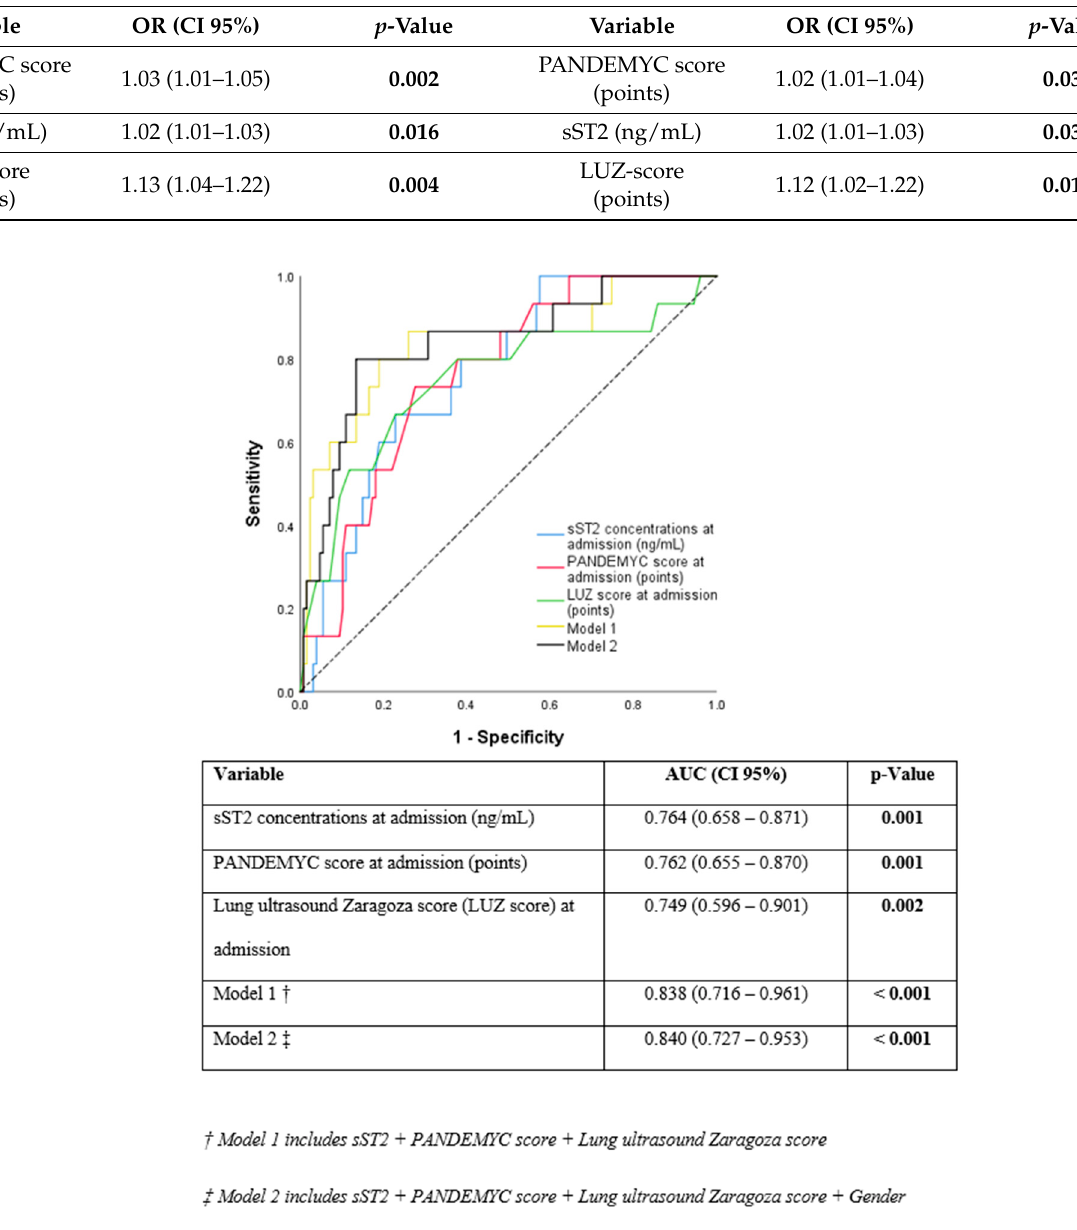
Figure 1. Receiver operating characteristic curves of the different models analyzed.